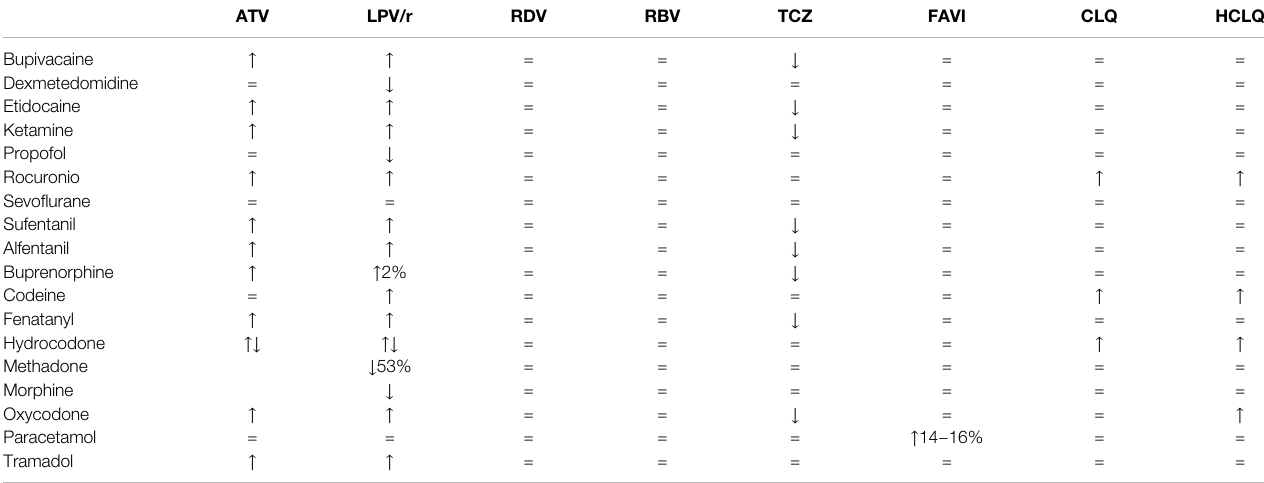
TABLE 1 | A summary of possible drug – drug interactions between the experimantal COVID-19 therapies and the main anesthesia-related medications. ATV LPV/r RDV RBV TCZ FAVI CLQ